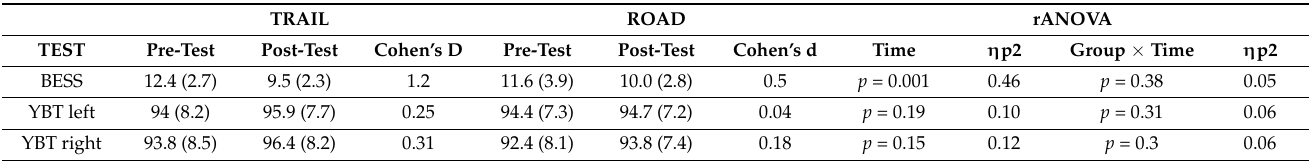
Table 3. Effect on balance of an 8-week trail and road running training intervention.